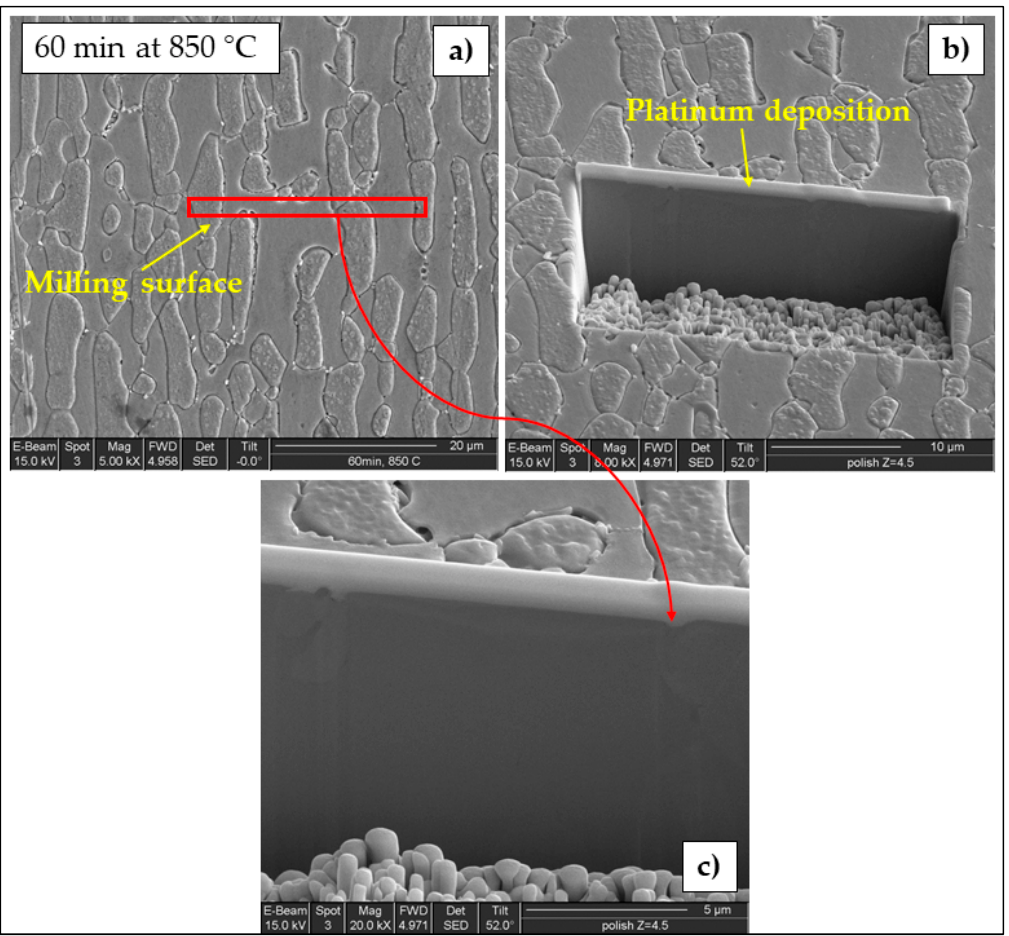
Figure 14. FEG-SEM images obtained on LDSS 2404 aged 60 min at 850 °C, after DL-EPR test, and before ( a ) and after ( b , c ) FIB milling.